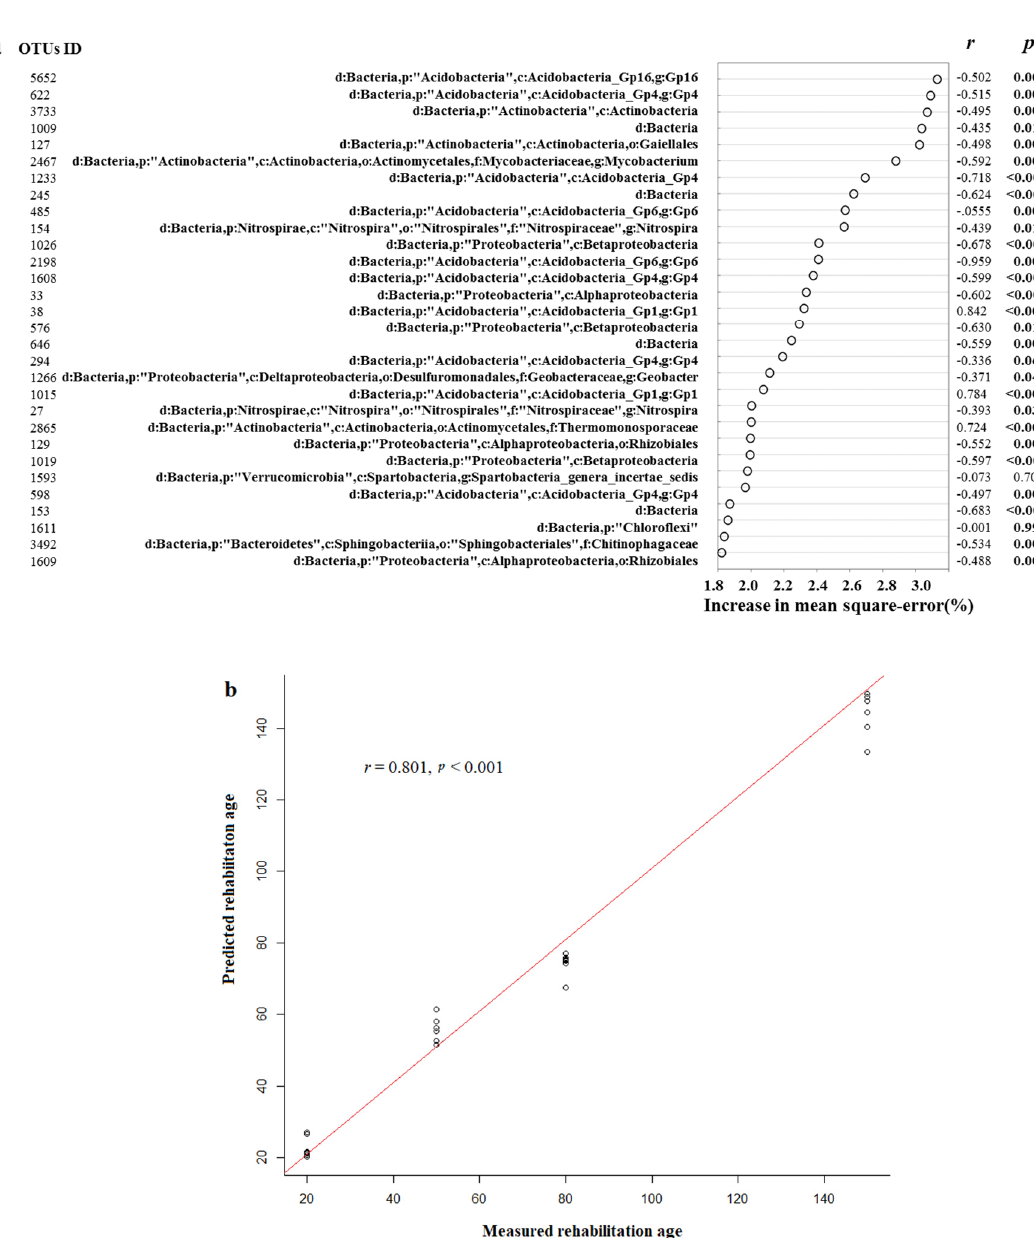
Figure 7. Rehabilitation age-discriminatory taxa for defining secondary succession level. ( a ) The top 30 rehabilitation age-discriminatory bacterial taxa and their correlation with rehabilitation age. Species are shown in descending order of their importance to the accuracy of the model. Importance was determined based on the percentage increase in mean-squared error of the microbiota rehabilitation age prediction when the relative abundance values of each taxon were randomly permuted. ( b ) The consistency (r = 0.801, p < 0.001) between the observed and diagnosed values is based on the profiles of rehabilitation age-discriminatory taxa in the secondary succession level.